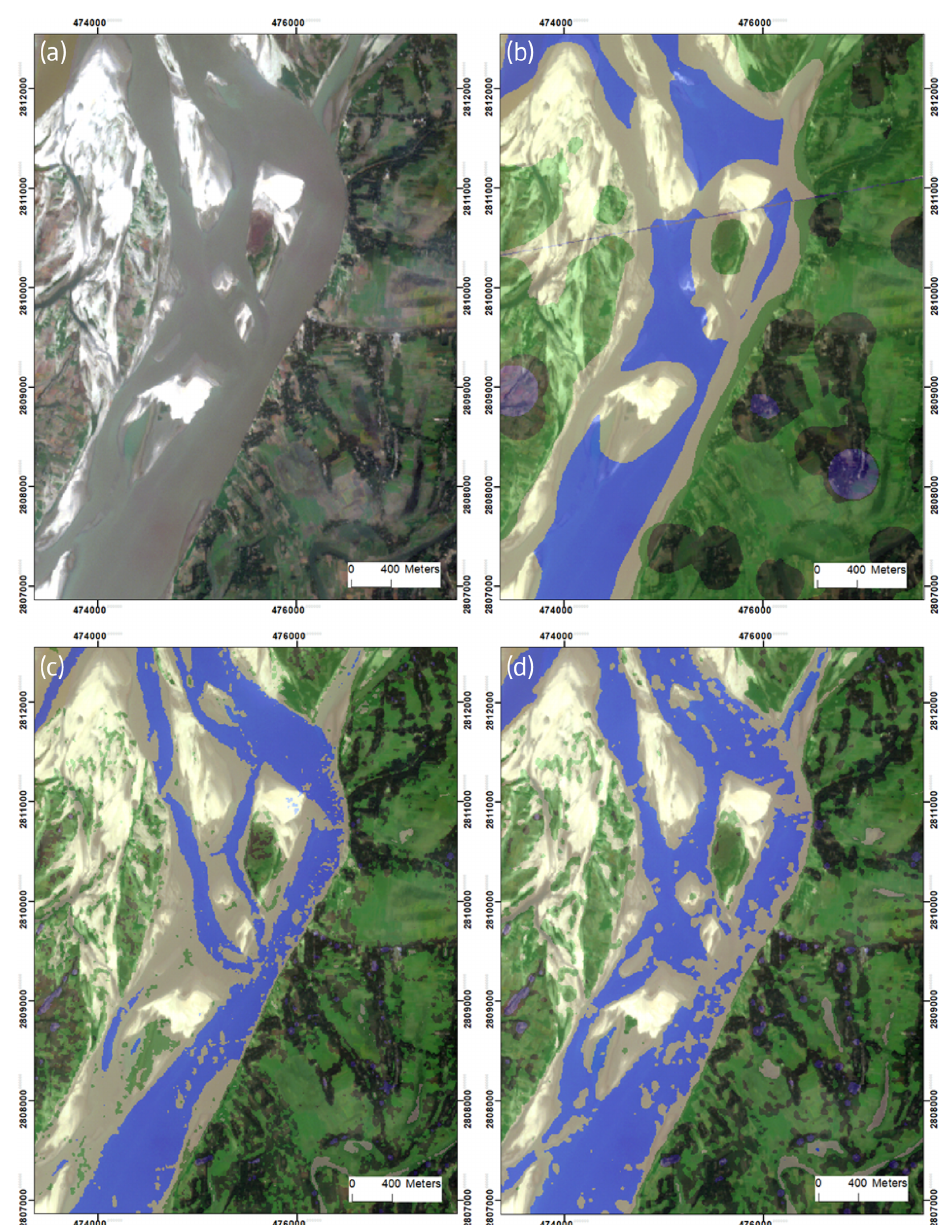
Figure 6. (a) Sentinel-2 image of a stretch of the eastern riverbank of Jamuna River, taken in November 2019. Image dimensions: ca. 4 . 5 × 6km. (b, c, d) Classification result for a sampling duration of 2 weeks and a 25 × 25 boxcar filter, 6 months and no filter, and 1 month and a 3 × 3 boxcar filter, respectively. Blue – water; sand – sand; light green – fields; dark green – trees. Source of optical background image: Sentinel-2. The location of the patch is shown in Fig. A1 (patch 1). Coordinates in this and all other maps are in Gulshan 303 Bangladesh TM (EPSG